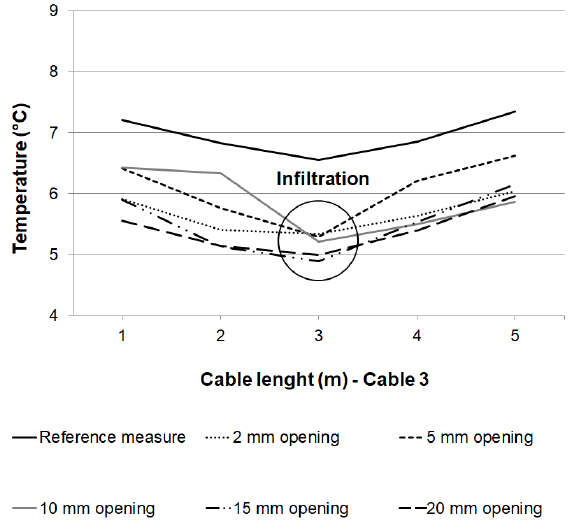
Figure 5 - Temperature-lenght: cable 3.